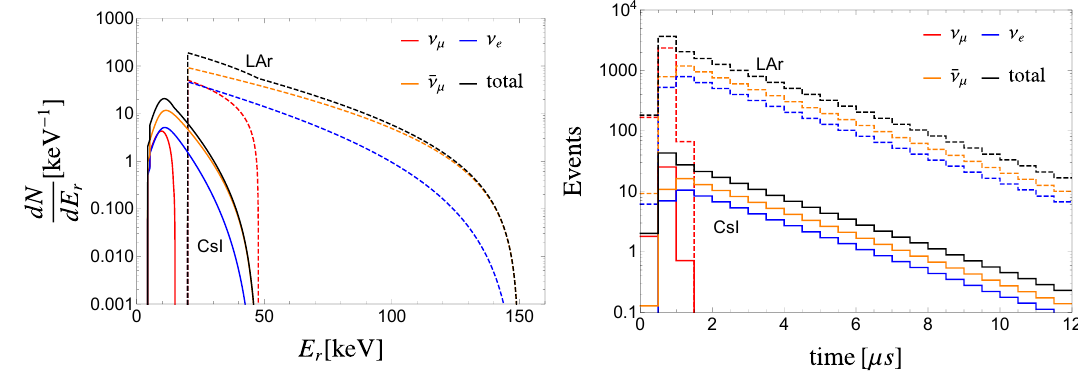
Figure 2. The SM recoil energy (left) and temporal (right) distributions in the current COHER- ENT CsI detector (solid lines) and a future COHERENT LAr detector (dashed curves). Threshold e(cid:11)ects are included. The red (blue) [orange] curves correspond to the contribution from muon (elec- tron) [anti-muon] neutrinos. The black lines correspond to the sum of all the (cid:13)avor